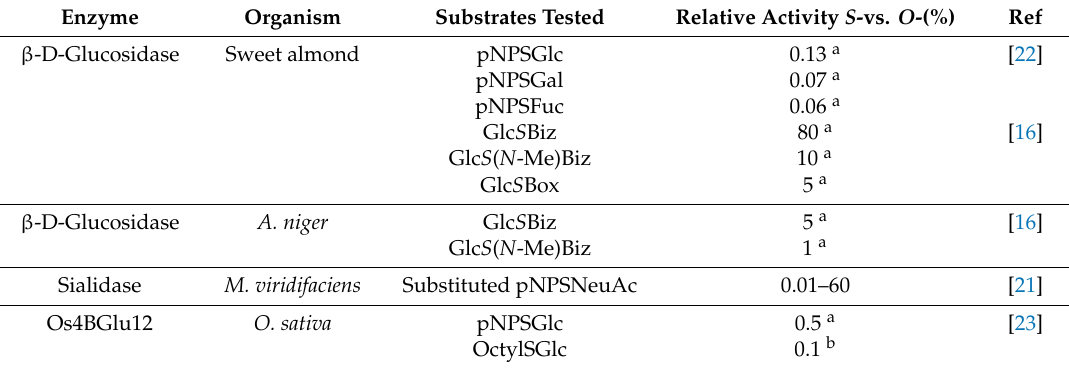
Table 1. Comparison of S - and O -glycoside hydrolysis by